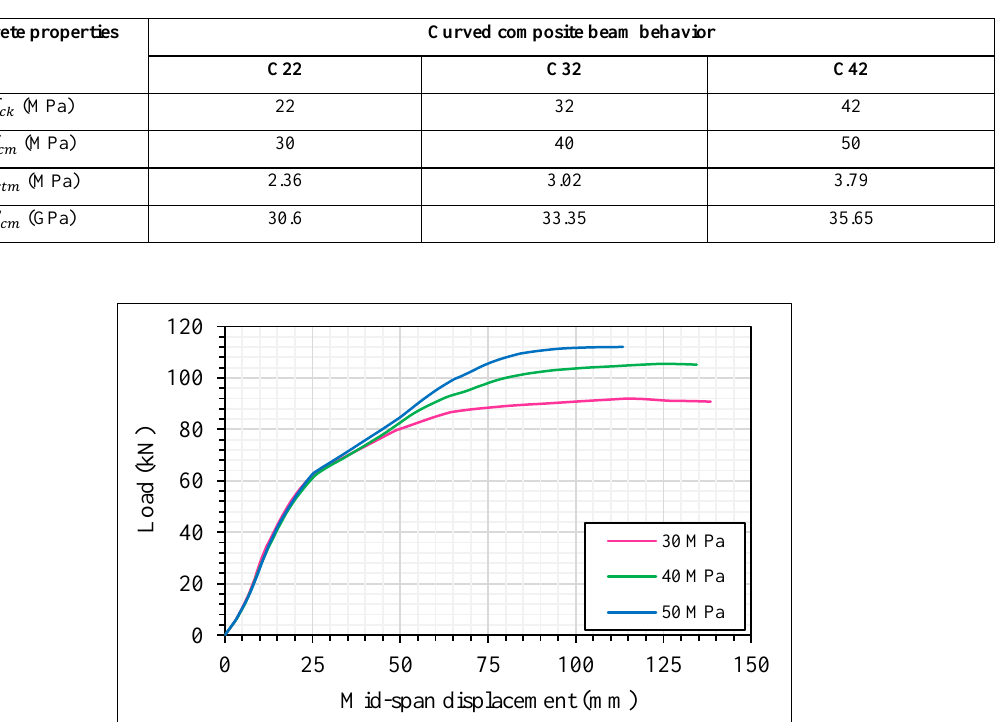
Table 7. The concrete slab properties for parametric study.